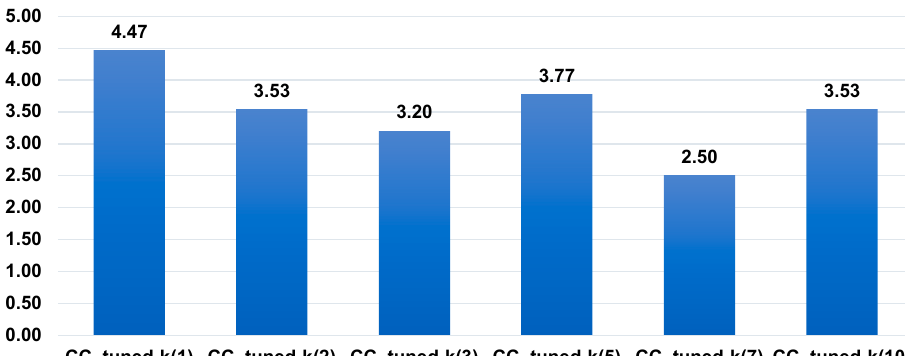
Figure 5. Convergence plots of CC-k algorithms. Benchmark problems are: ( a ) F 1 ; ( b ) F 2 ; ( c ) F 3 ; ( d )